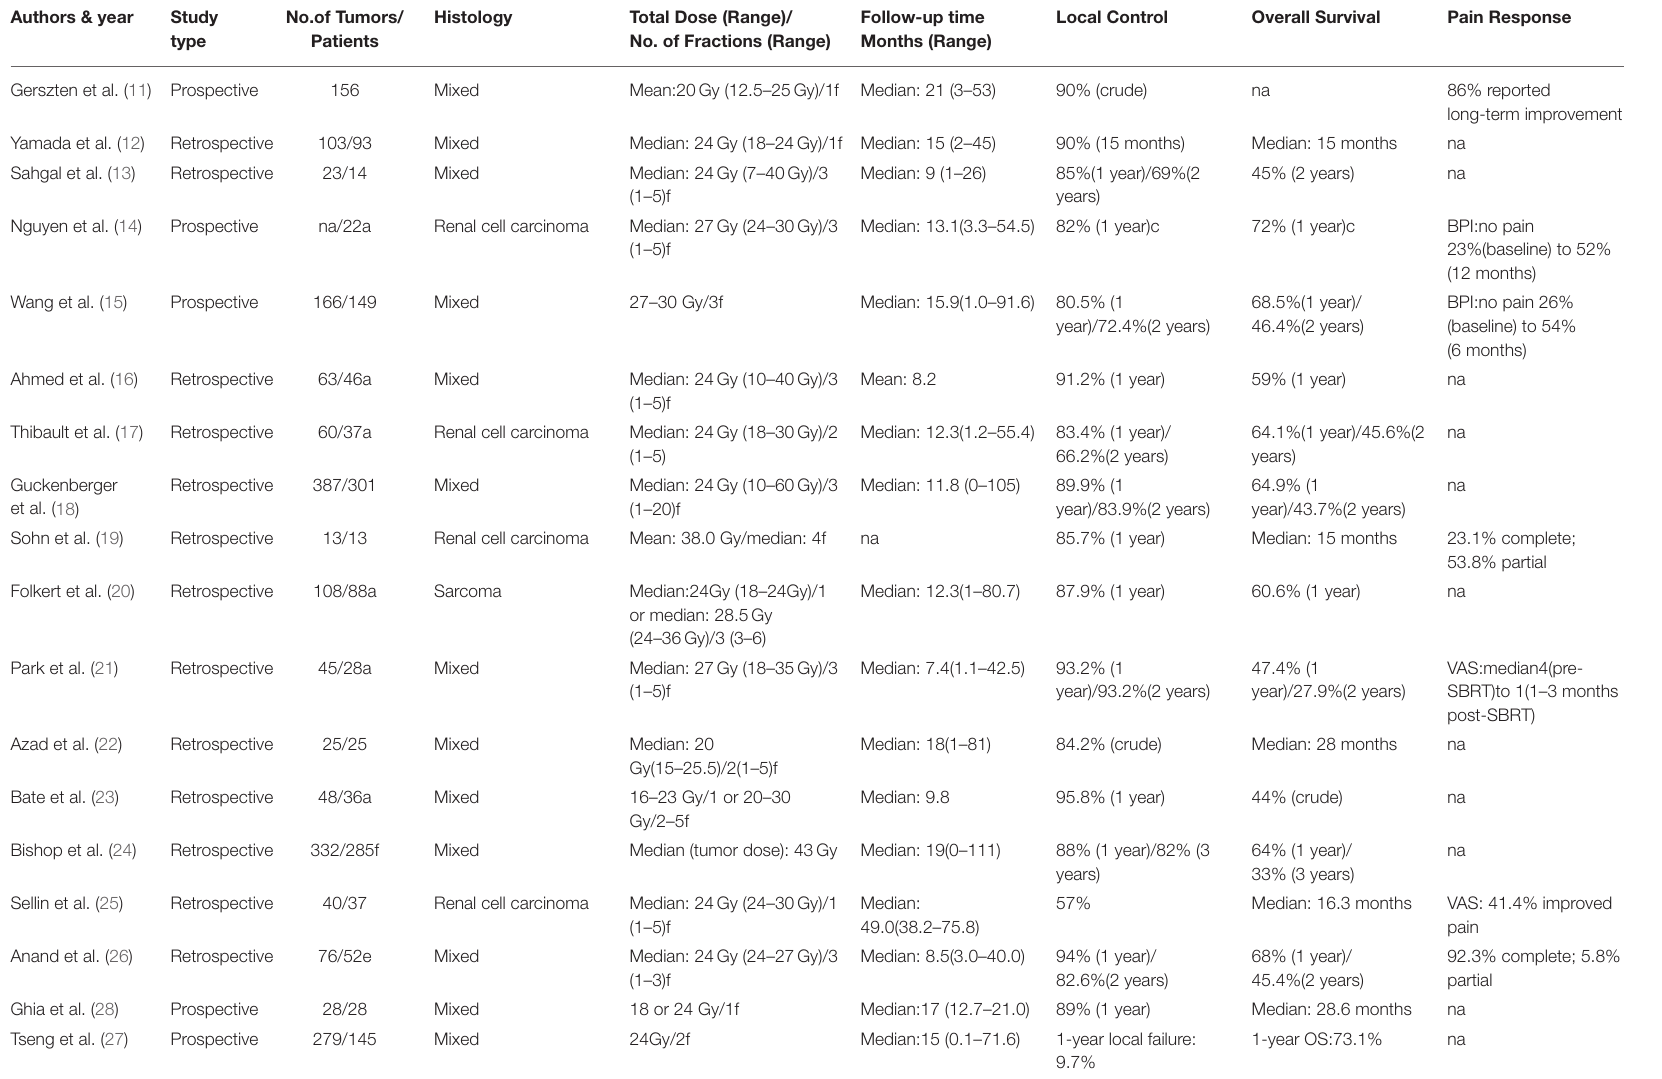
TABLE 1 | Selected spine SBRT series for spinal metastases with no prior history of